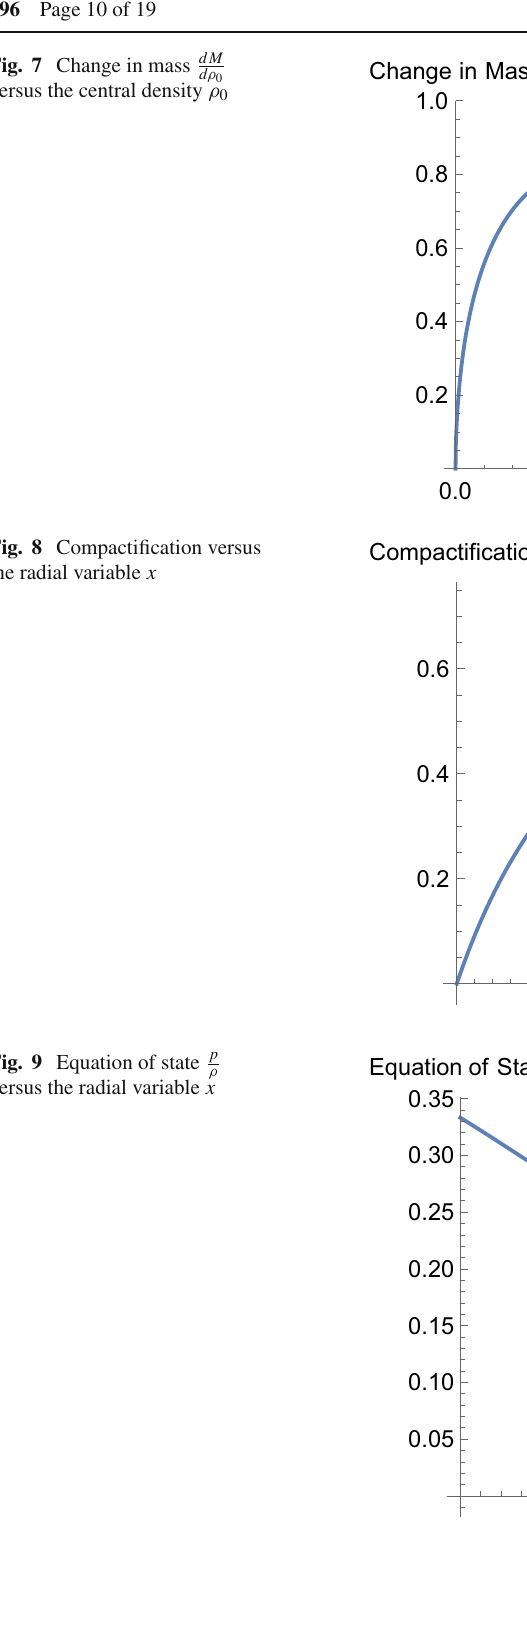
Fig. 7 Change in mass dM versus the central density ρ 0